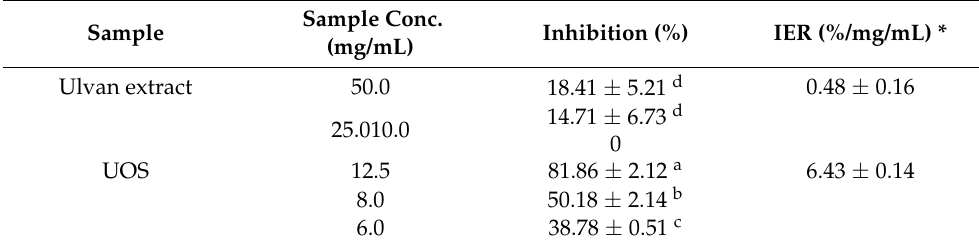
Table 3. ACE inhibition on ulvan extract and ulvan oligosaccharides